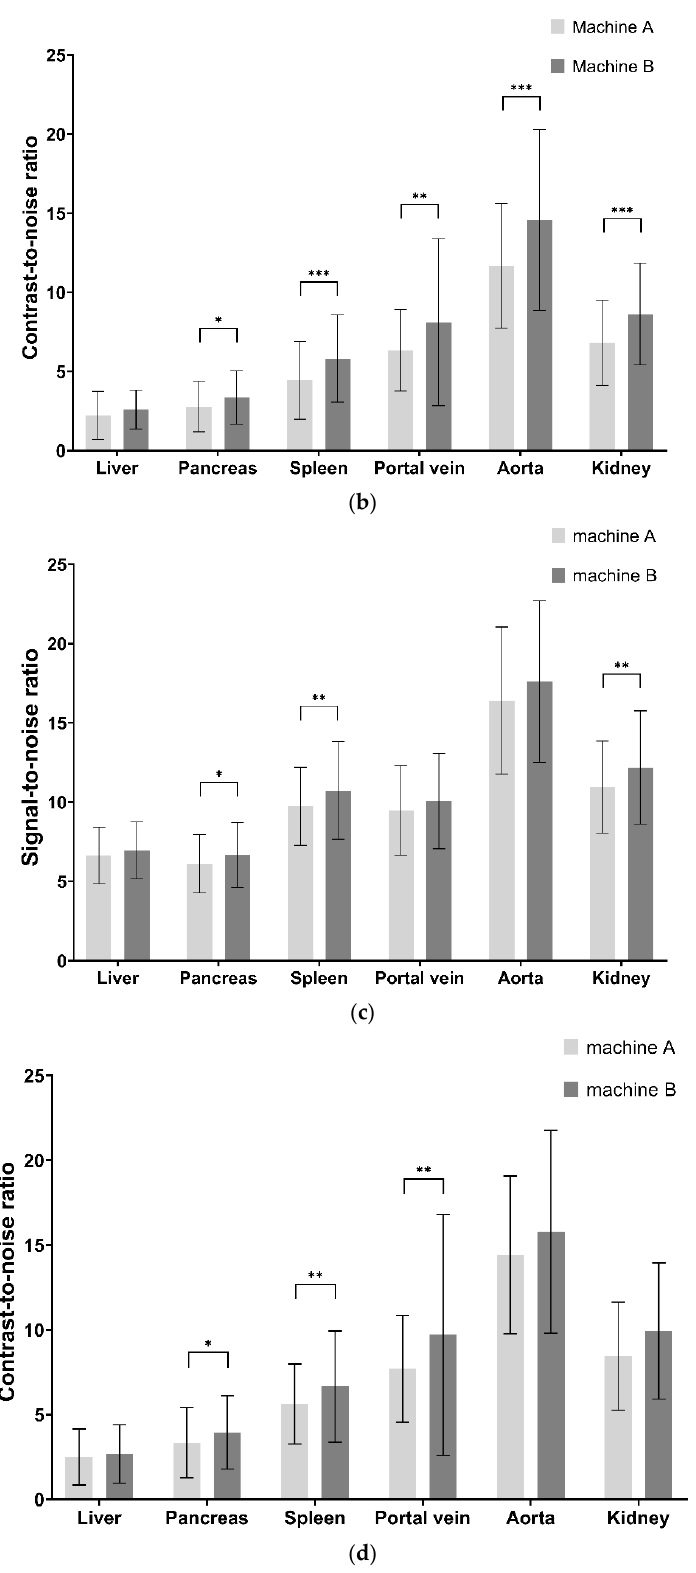
Figure 2. Differences in the signal-to-noise ratio (SNR) and contrast-to-noise ratio (CNR) between the two machines in each group SNR and CNR of the organs in Group A ( a , b ) and Group B ( c , d ), respectively. * p < 0.05; ** p < 0.01; *** p <